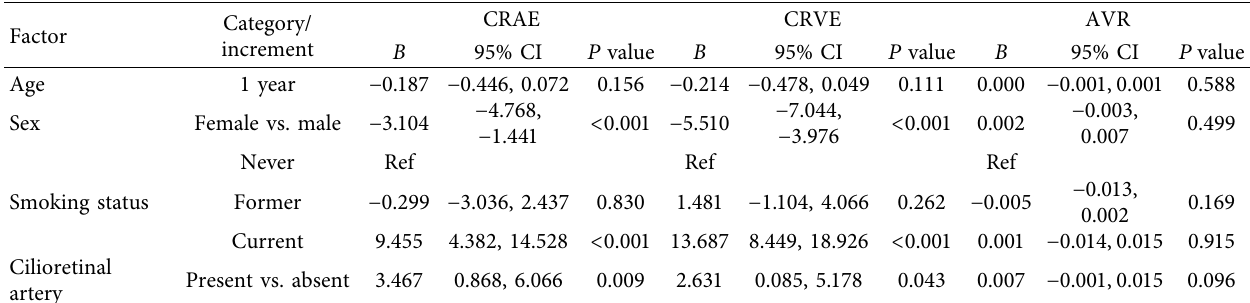
Figure 2: Relationship of retinal vessel parameters with age. Scatterplots showing the relationship of age with (a) Central Retinal Arteriolar Equivalent (CRAE); (b) Central Retinal Venular Equivalent (CRVE); (c) Arteriole-to-Venule Ratio (AVR), with regression trend Table 2: Relationship of retinal vessel diameters with clinical characteristics.